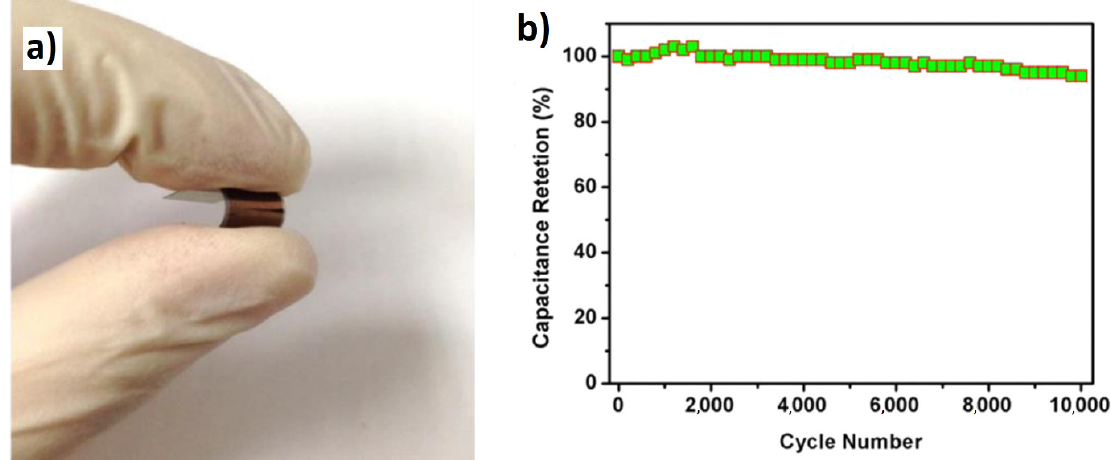
Figure 13. ( a ) Digital picture of the solid-state device (size ~1 cm × 0.8 cm) under folded conditions; ( b ) Cycling stability of the device at a current density of 2 Ag − 1 . Reprinted from ref. [70] with permission from Elsevier Ltd.